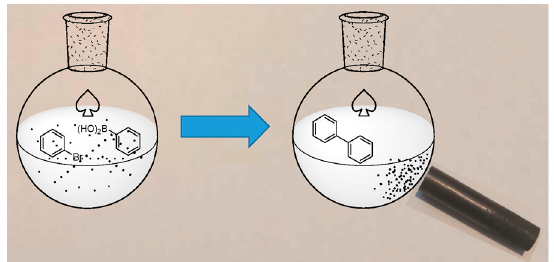
Figure 1. Application of an external magnetic field that collects the catalyst and withholds it in the reaction flask making it possible to decant the product mixture. The catalyst can then be washed and used in another cross-coupling reaction immediately afterwards.